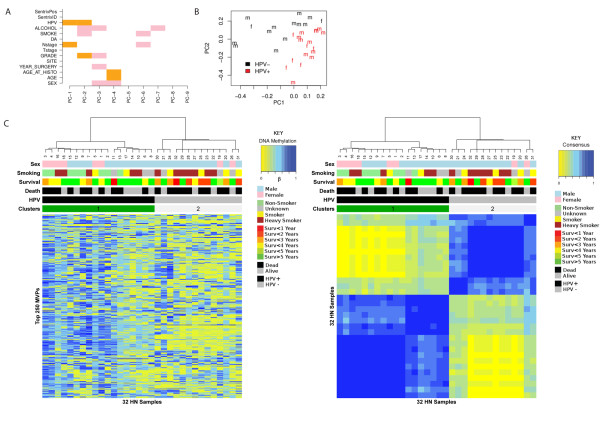
Unsupervised analysis of the top 250 methylation variable positions (MVPs) in formalin-fixed, paraffin wax-embedded (FFPE) human papillomavirus-positive (HPV+) and HPV-negative (HPV-) tumor samples. (A) Singular value decomposition: PC-k denotes the kth principal component, DA denotes survival at censoring date. The first two principal components PC-1 and PC-2 most strongly correlated with HPV status, whereas the remaining significant components associated with clinical parameters, including alcohol consumption, smoking, age, sex, tumor stage, and grade. No association was found with technical factors (such as Sentrix position and Sentrix ID) on the array. (B) The first two principal components clearly distinguish HPV status. HPV+ samples are plotted in black, HPV- samples are in red, and m/f indicates male/female. (C) Clusters inferred by the unsupervised consensus-clustering algorithm for the top 250 MVPs as found using the MAD estimator.